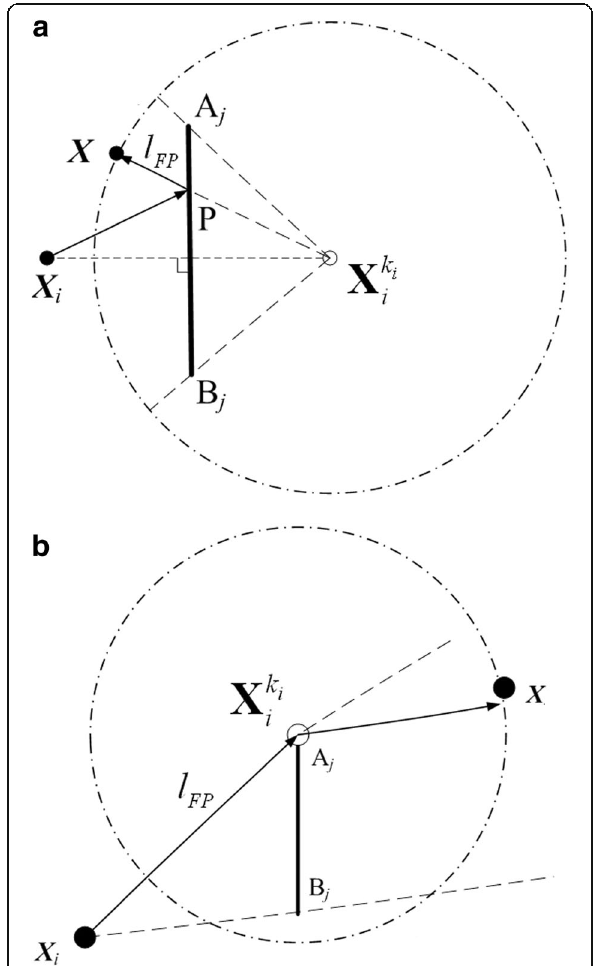
Fig. 1 TOA model of reflection and diffraction. a Reflection. b